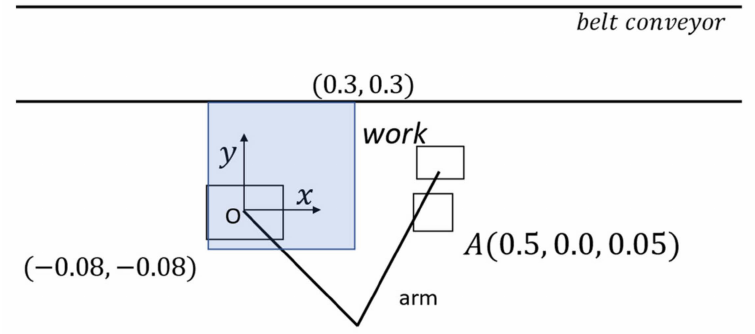
Figure 6. Optimal robot placement and motion planning